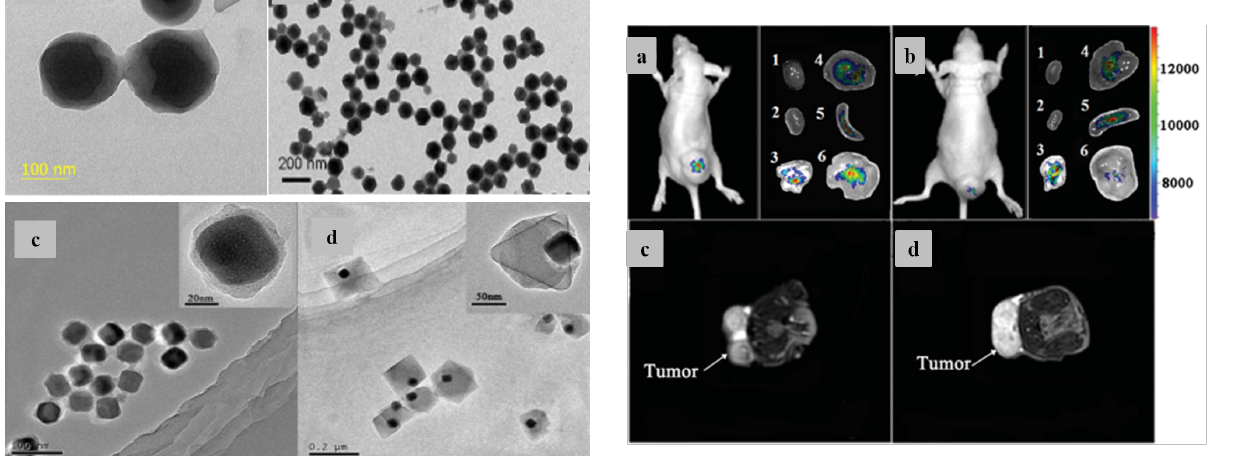
Figure 8: a) HRTEM image of NaYF 4 : Yb 3+ , Er 3+ @ZIF-8. b)TEM im- age of UCNPs-g-C 3 N 4 -CDs@ZIF-8. c) UCNP@Fe-MIL-101_NH 2 inter-